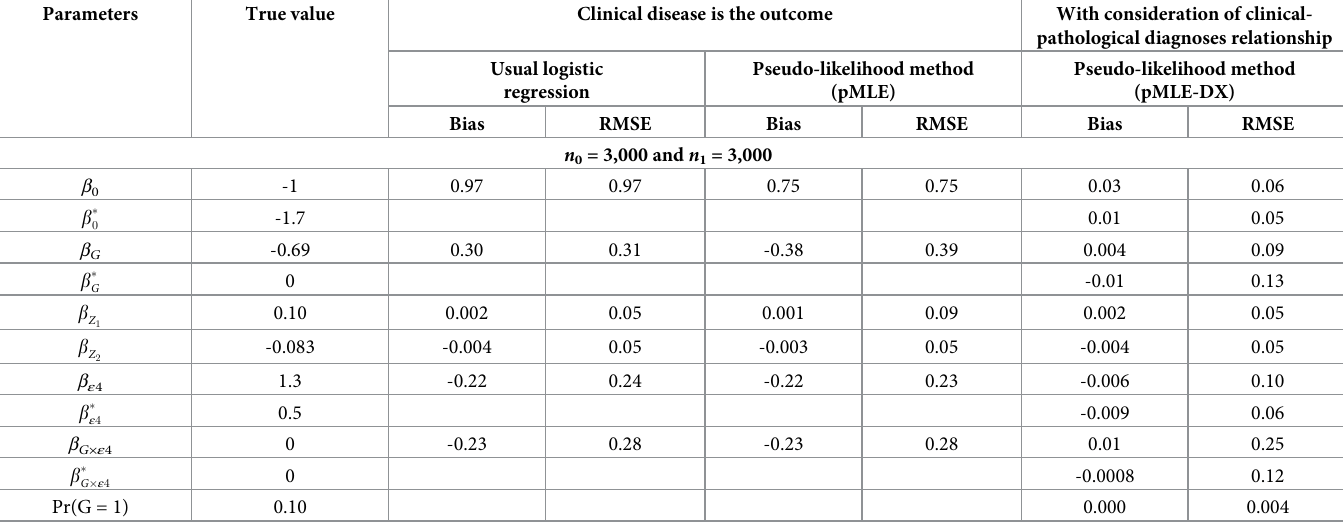
= 0, β G × ε 4 = 0 and β (cid:3) = 0. G G (cid:2) ε 4